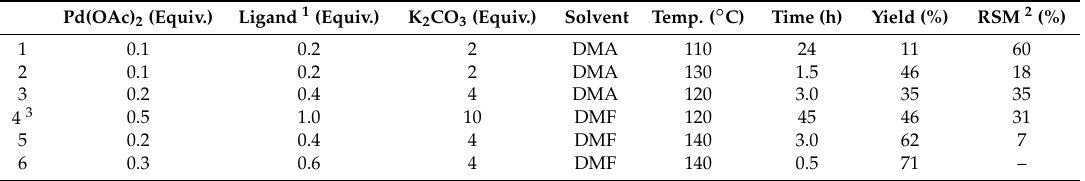
Table 1. Optimization of the Heck-type cyclization of 18a to olivacine ( 1 ).